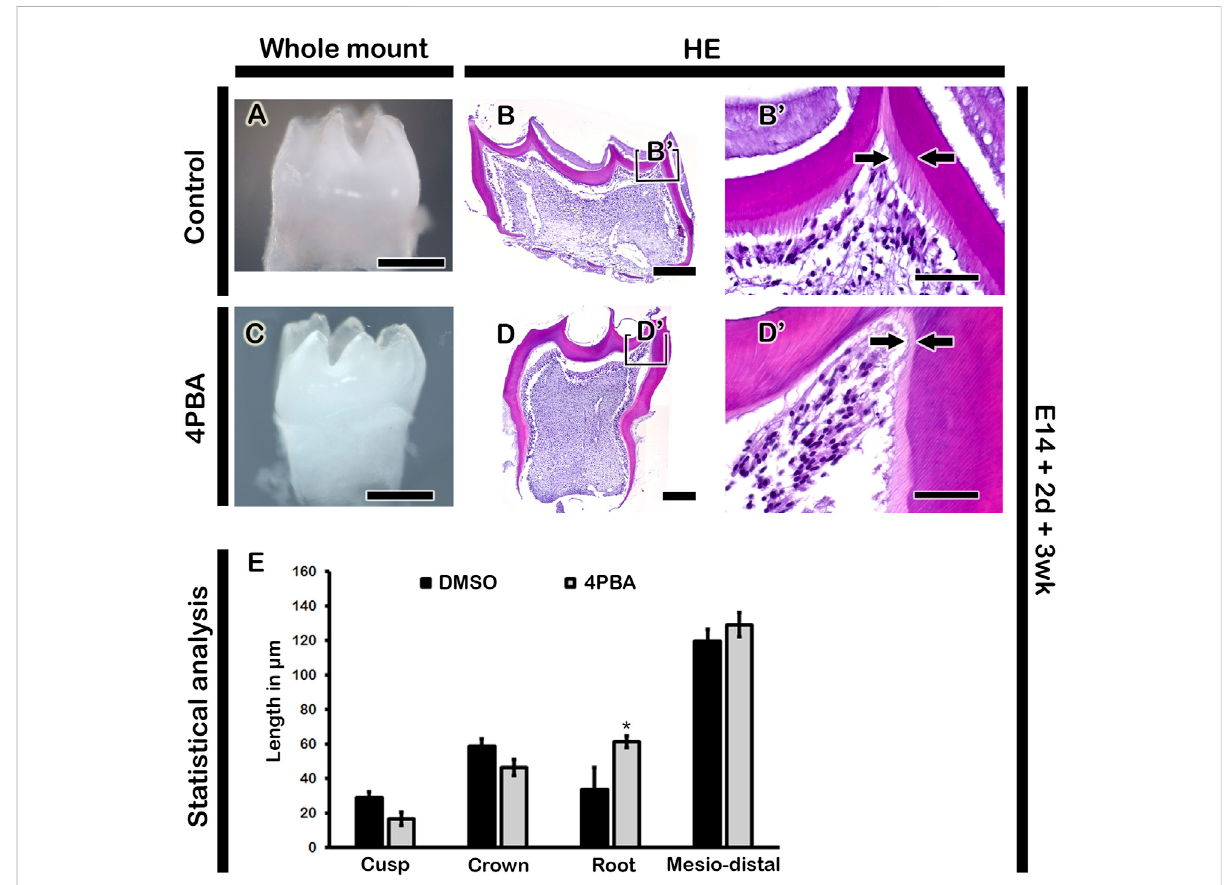
FIGURE 5 Morphology and histology of renal calci fi ed teeth. The 3-week renal calci fi ed teeth showing elongated tooth roots in the 4PBA treated group when compared to control (A, C) . Thicker predentin in the cuspal area in the 4PBA treated teeth (B 9 , D 9 ) . Boxes in B and D indicate enlarged views. Arrows indicatethickness ofpredentin (B 9 ,D 9 ) .Scalebars:500 μ m (A,C) ,200 μ m (B,D) , 50 μ m (B 9 ,D 9 ) .Statisticalanalysis showingcusp, crown,root and mesio-distal lengths in the control and 4PBA treated group (E) . N = 5. * indicates p <